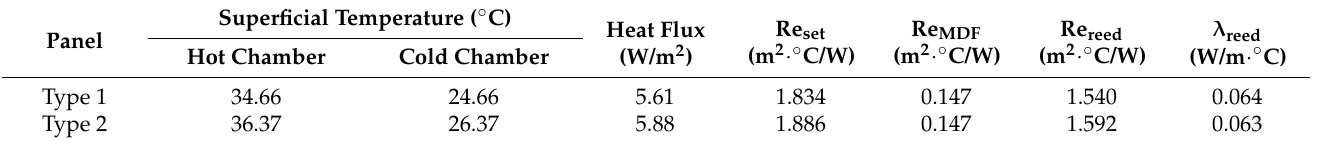
Table 4. Parameters monitored during the hotbox and the thermal properties of the studied reed panels.